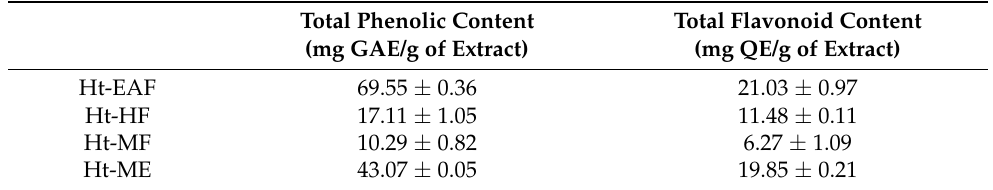
Table 1. Total phenolic and total flavonoid content in different fractions and methanolic extract of H. tuberosus . GAE: Gallic acid equivalent; QE: quercetin